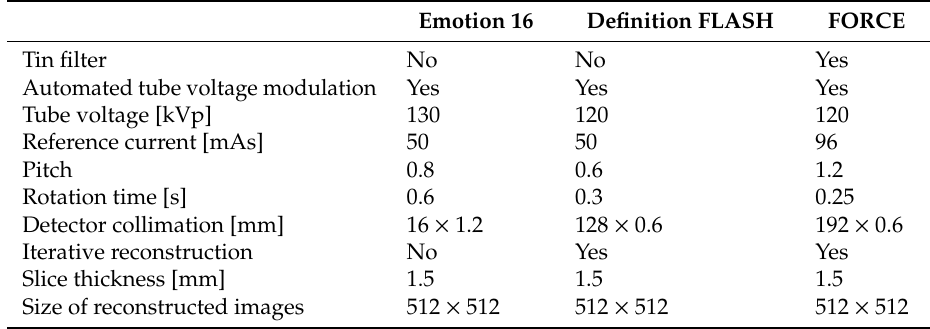
Table 1. Protocol settings and reconstruction algorithms used at the three considered computed tomography (CT)